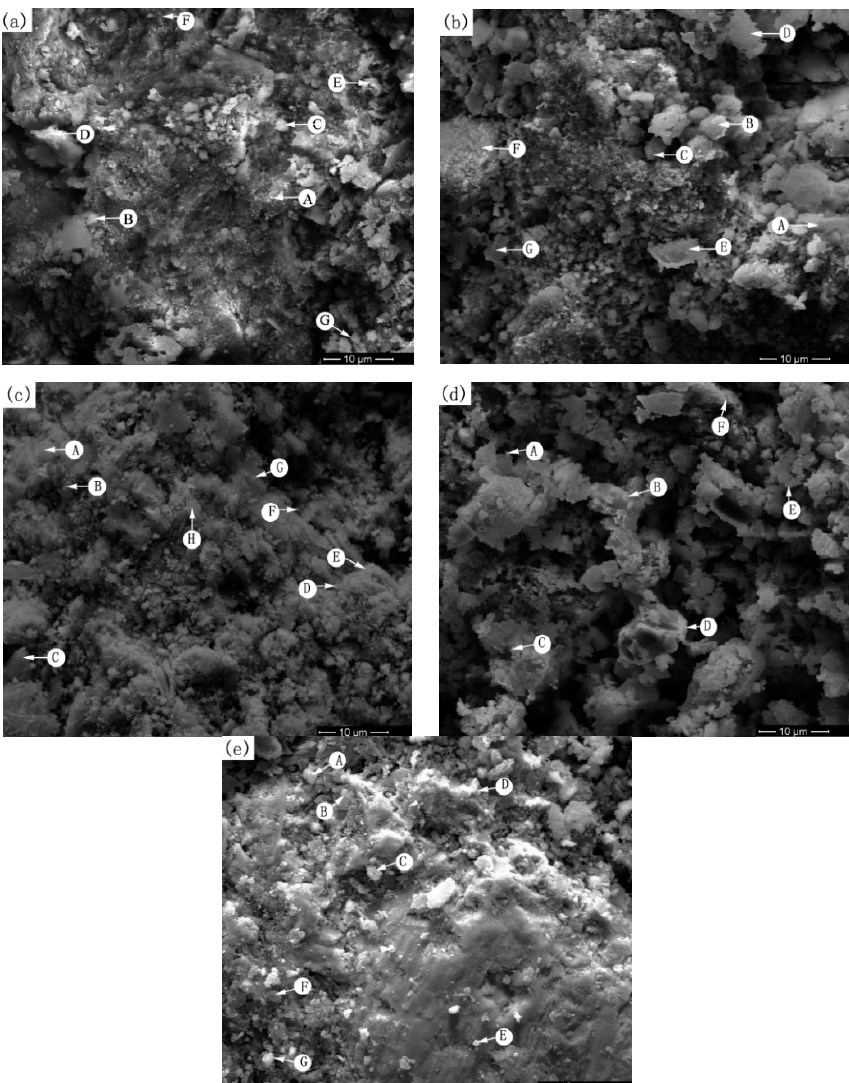
Figure 6. SEM images of the roasted ore in air atmosphere and at different roasting temperatures: ( a ) Raw material; ( b ) 700 °C; ( c ) 800 °C; ( d ) 900 °C; ( e ) 1000 °C.